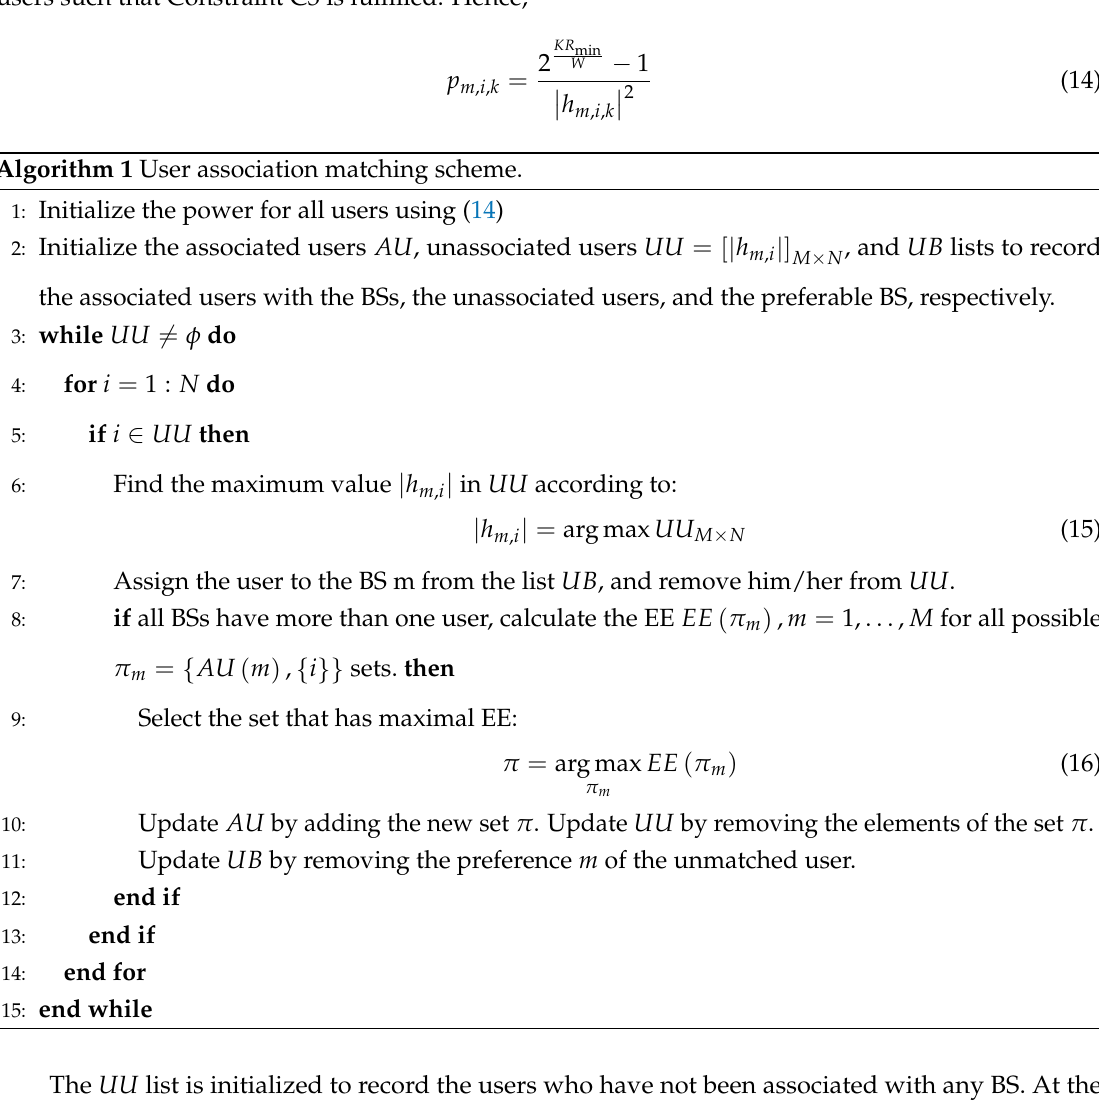
Algorithm 1 User association matching